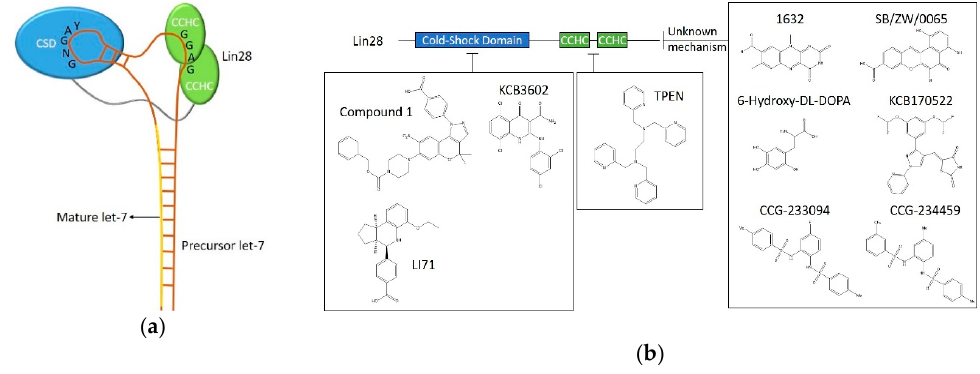
Figure 1. Targeting the Lin28/let-7 pathway. ( a ) Interactions between Lin28 and pre-let-7. Cold-shock domain (CSD) and tandem CCHC motifs of Lin28 are shown in blue and green, respectively. Pre-let-7 is shown in orange and mature let-7 in yellow. CSD and CCHC domains bind to the terminal loop of pre-let-7 at GNGAY and GGAG motifs, respectively. ( b ) Disruptors of Lin28/let-7 identified from HTS. CSD and CCHC motifs of Lin28 are shown in blue and green, respectively. Hit compounds identified through HTS as being disruptors of Lin28/let-7 are displayed. The targeting domains are notified. Disruptors with unclear mechanisms are pointed out.